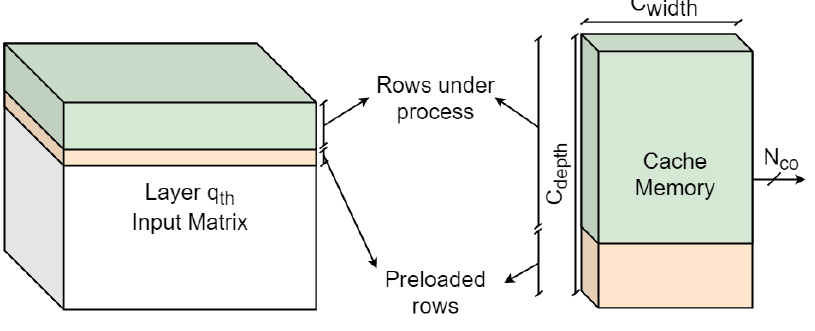
Figure 3. Custom cache scheduling